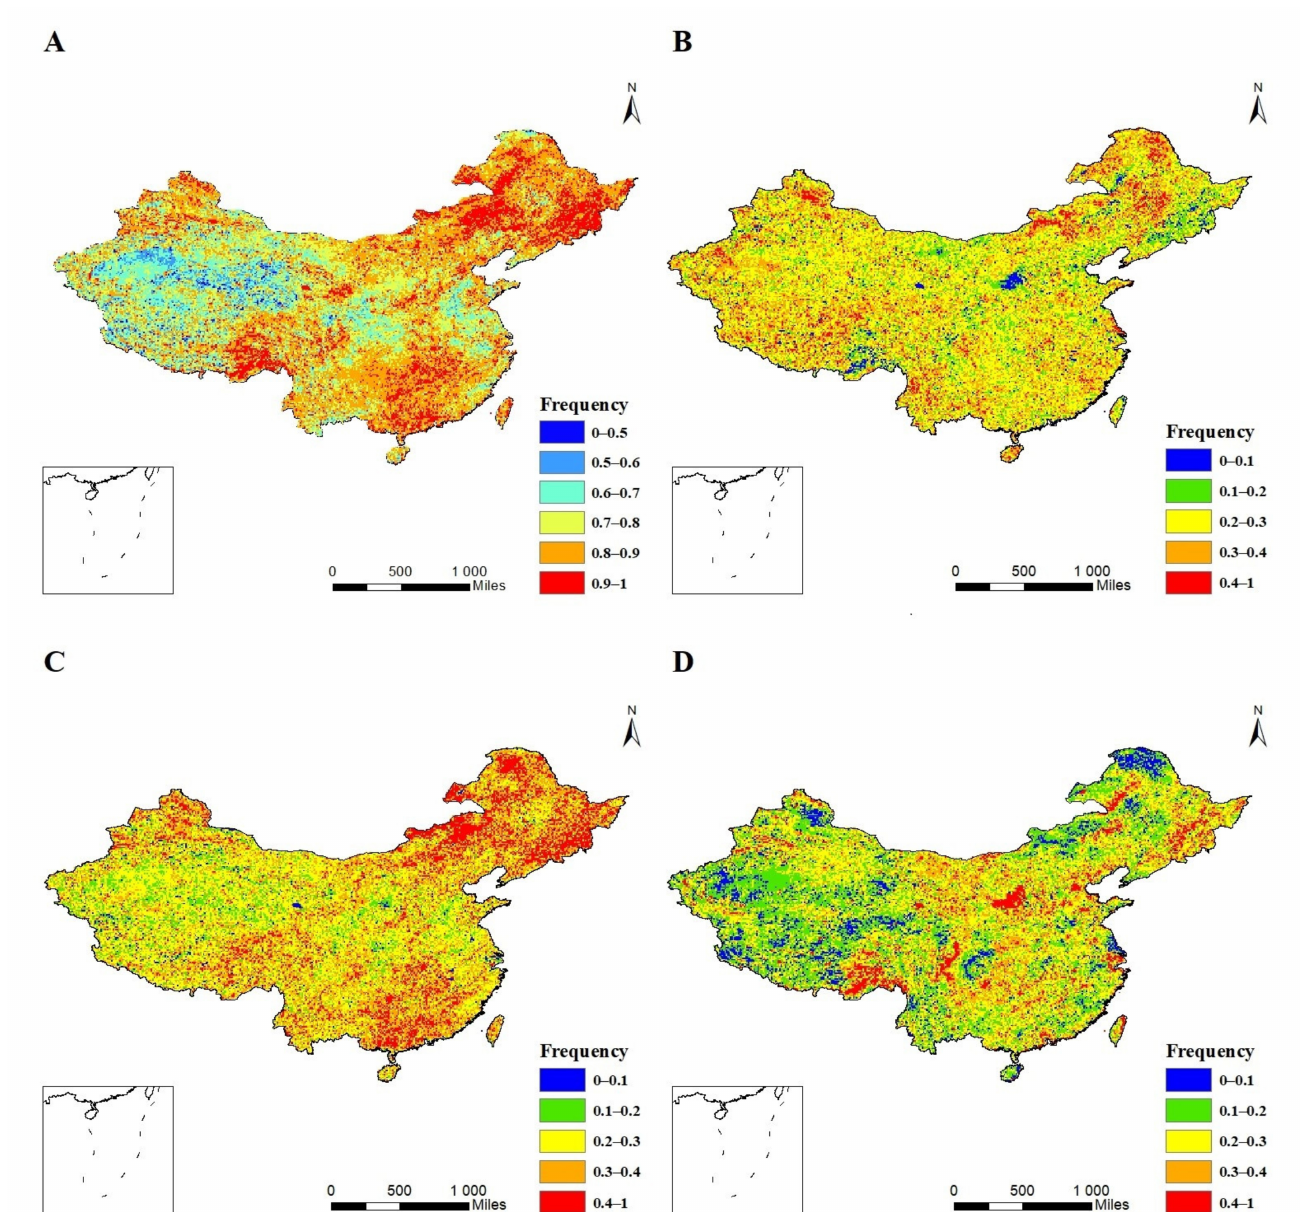
Figure 2. Spatial distribution of drought occurrence frequencies for different drought grades during spring in China. ( A ) total drought occurrence frequencies; ( B ) slight drought occurrence frequencies; ( C ) moderate drought occurrence frequencies; ( D ) severe drought occurrence